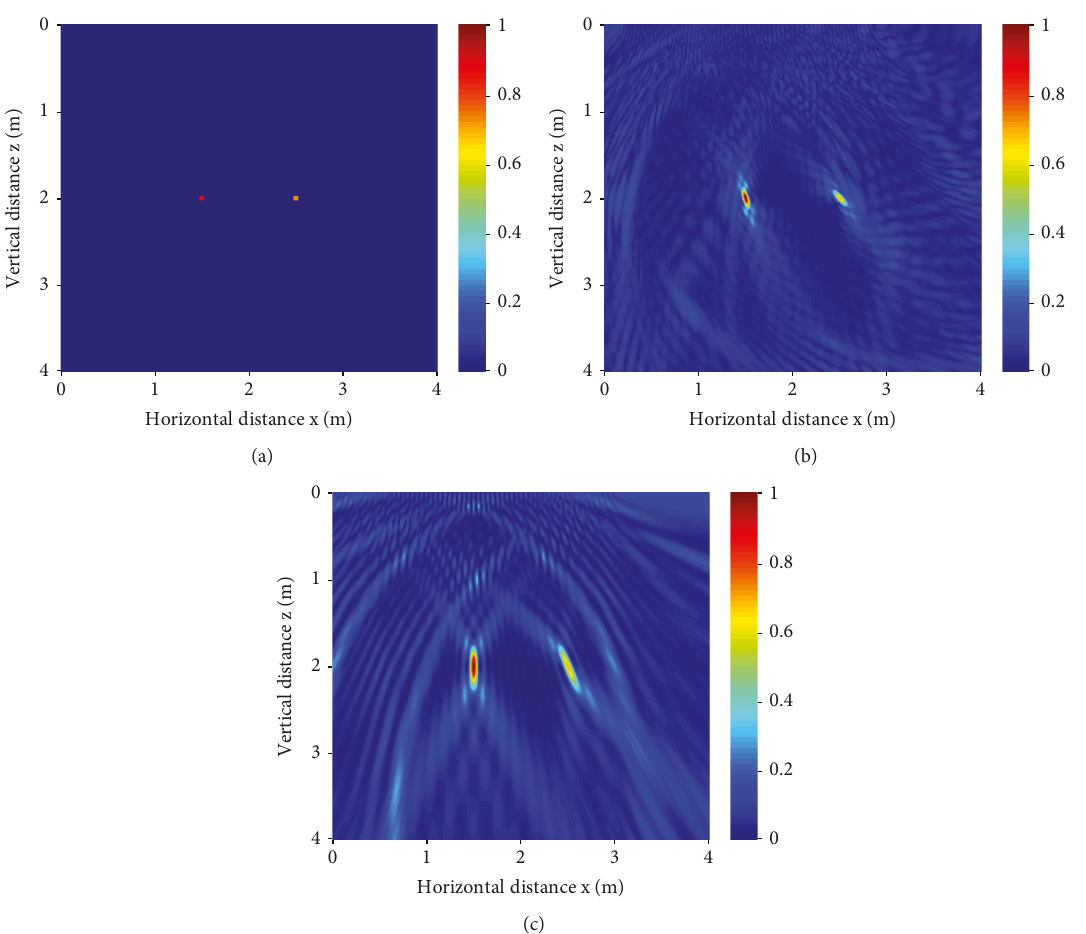
Figure 5: One strong target and one weak target detection: (a) actual position of targets, (b) FDA-MIMO radar, and (c) conventional MIMO